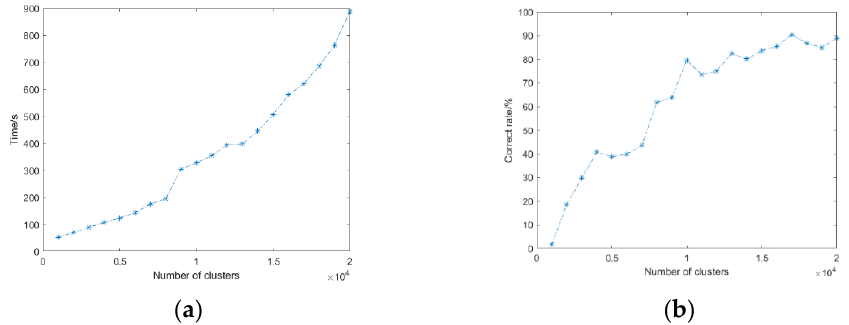
Figure 9. ( a ) Relationship between the cluster number and calculation time; ( b ) relationship between cluster number and accuracy.